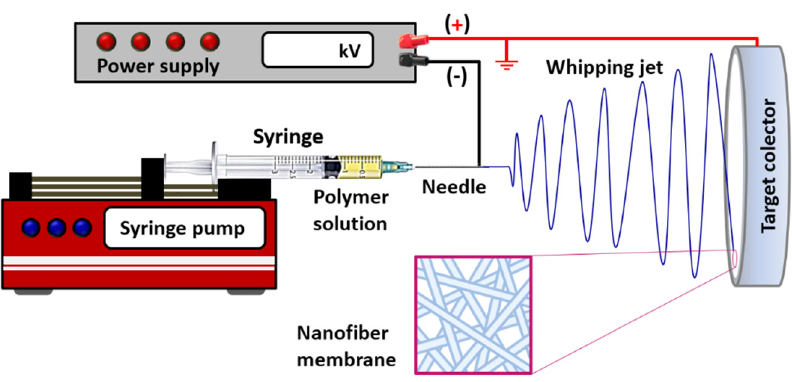
Figure 3. Schematic illustration of the electrospinning process and the fibrous structure achieved.